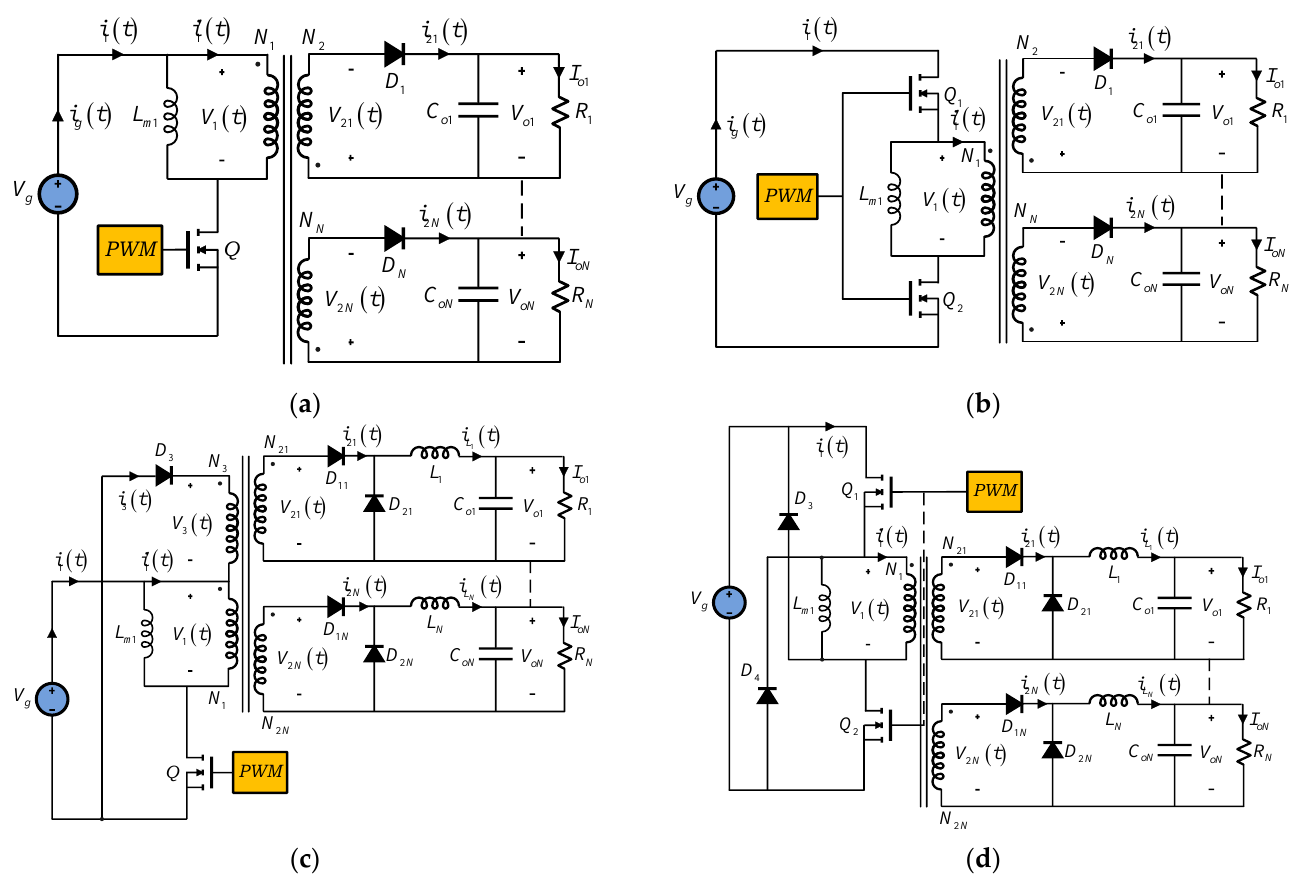
Figure 3. Multiple-Output Isolated DC – DC Converters Topologies. ( a ) Single-Switch Flyback Converter. ( b ) Two-Switch Flyback Converter. ( c ) Single-Switch Forward Converter. ( d ) Two-Switch Forward Converter.